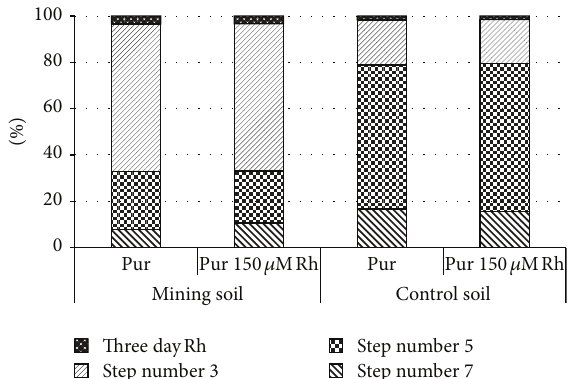
Figure 3: The percent uranium removed from each of the four relevant steps of the sequential extraction was compared (see Table 2). The speciation of the uranium could be determined by comparing the rhamnolipid solutions to the corresponding water only